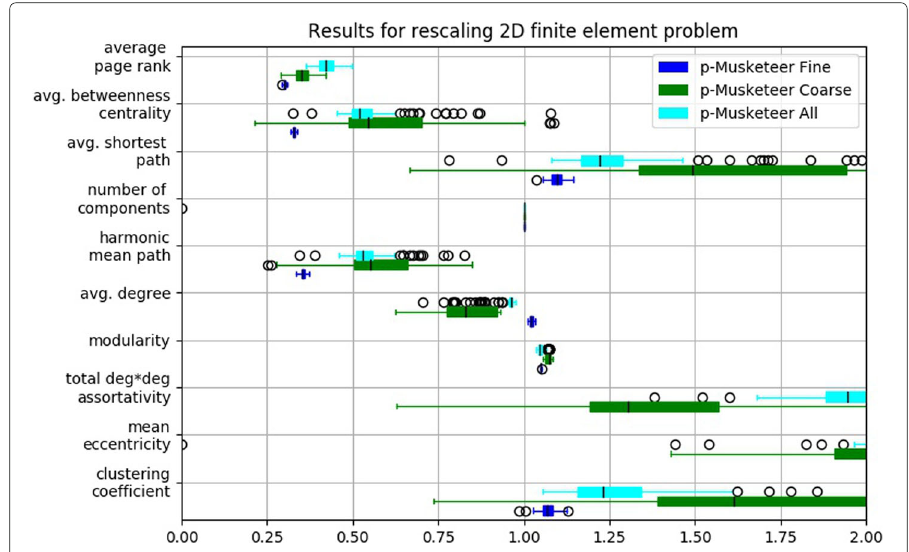
Fig. 23 Computational results on performance of planar Musketeer 2D finite element graph with 1866 nodes and 3538 edges rescaled to at least 4000 nodes and 7000 edges